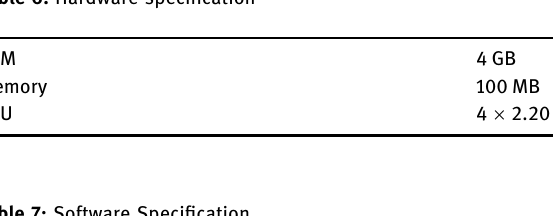
Table 7: Software Speci fi cation